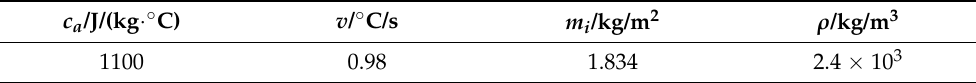
Table 3. Values in Equations